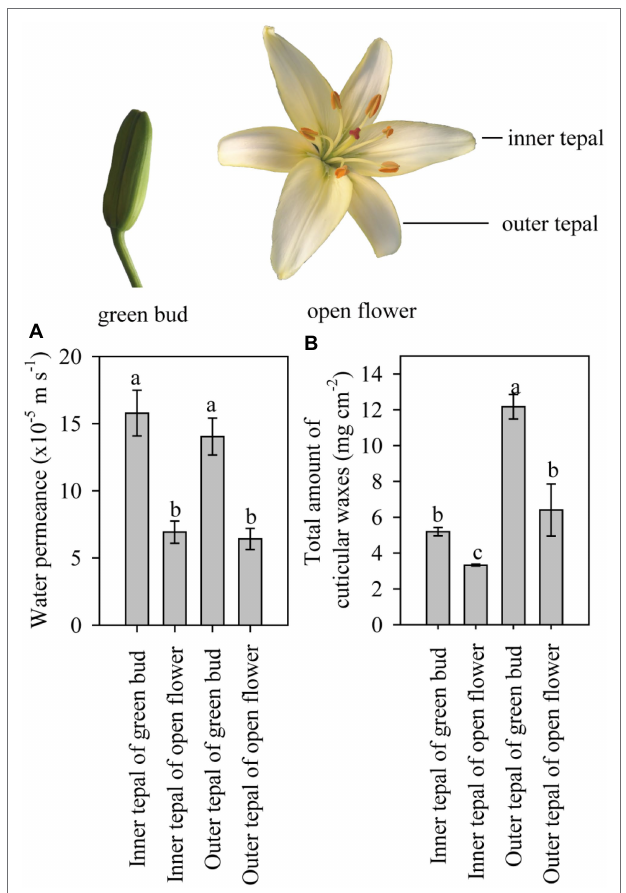
FIGURE 2 | Cuticular transpiration rate and wax coverage of tepals of lily flowers at the green bud and open stages. (A) Minimum water conductance and (B) total amount of cuticular waxes on the inner and outer tepals of green buds and open flowers of the Lilium cultivar ‘Casa Blanca’. Data are presented as the mean ± standard deviation ( n = 12 for transpiration, n = 5 for cuticular wax). The different letters on the bars indicate significant differences ( p < 0.05).